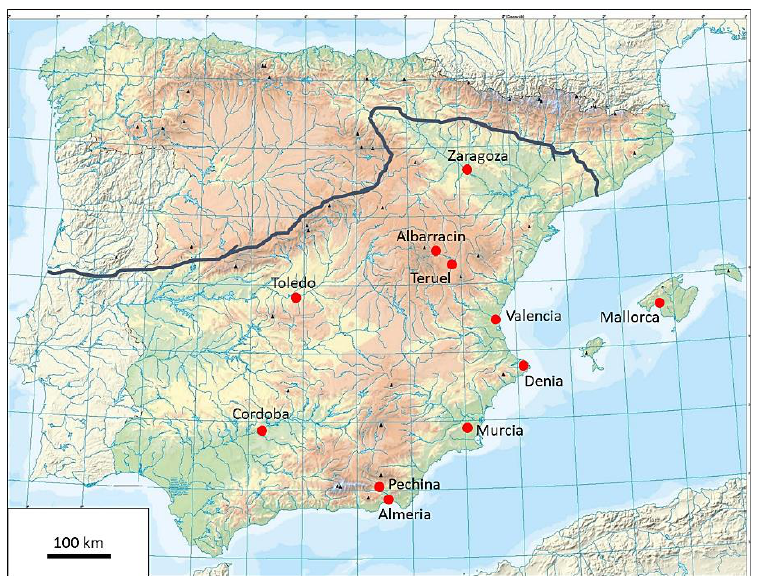
Figure 1. Map of the Iberian Peninsula, showing the approximate border between Islamic and Christian areas at the beginning of the 11th century CE, with some of the main centers of ceramic